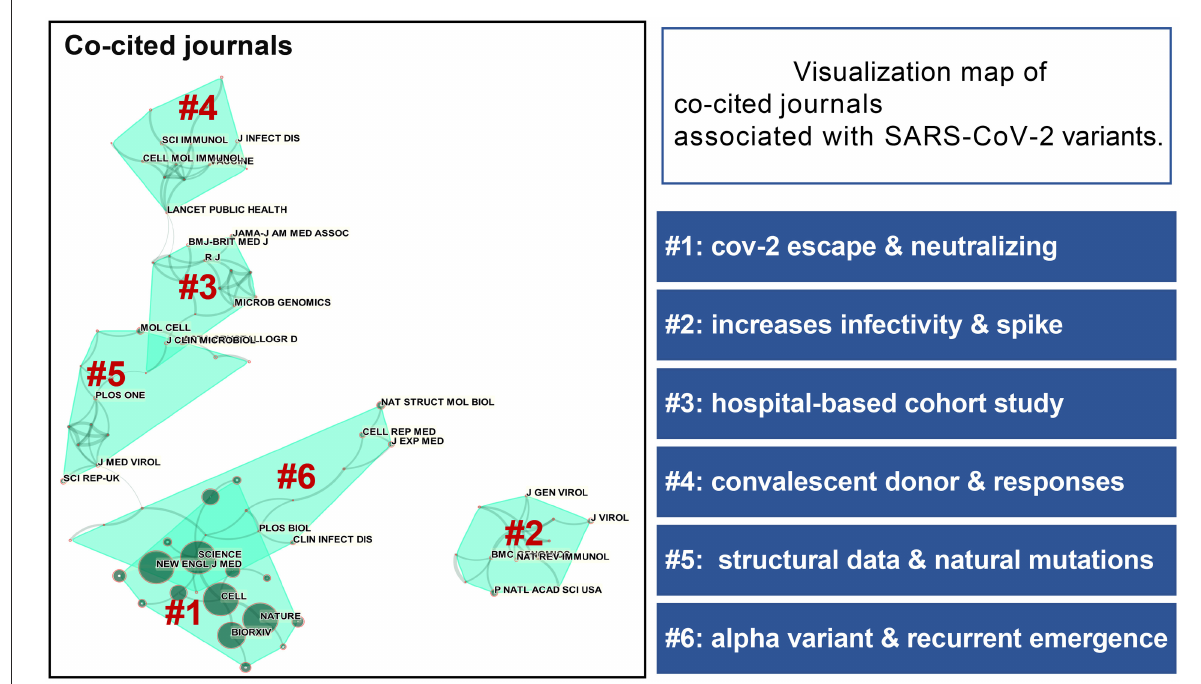
FIGURE4 Visualization map of co-cited journals associated with SARS-CoV-2 variants and corresponding clusters based on research direction. The size of the circles indicates the number of co-citations. Lines between categories indicate cross-linkages between study directions.